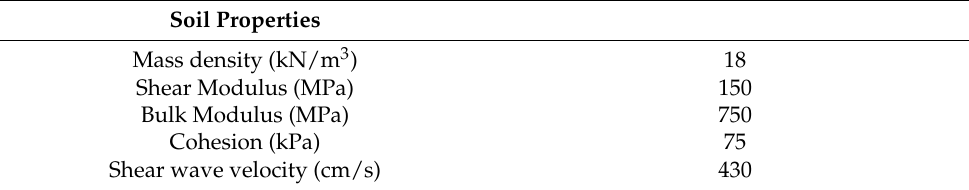
Figure 6. Benchmark bridge. Table 2. PressureIndependMultiYield model: soil